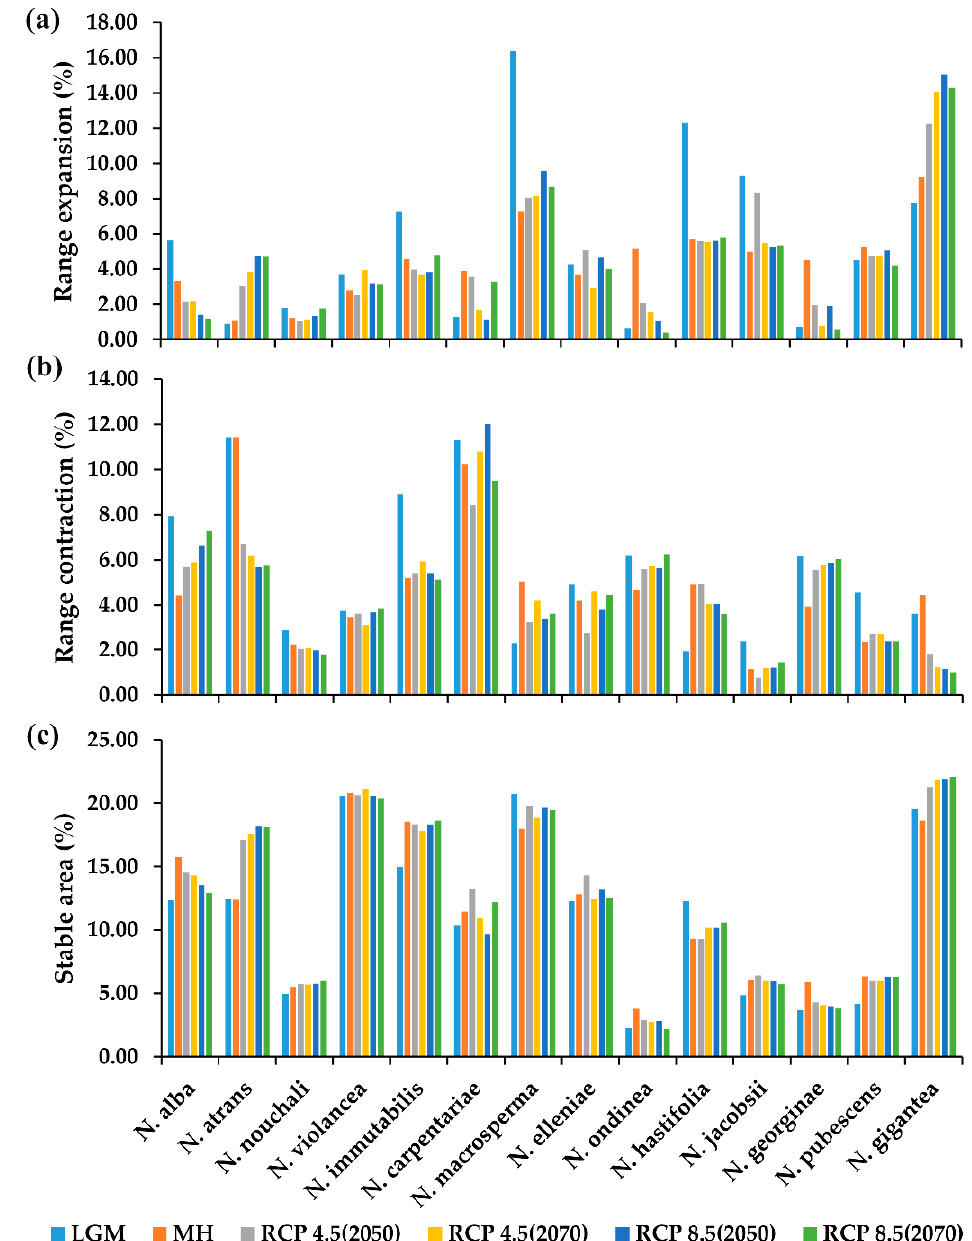
Figure 3. Change in habitat suitability for the past and future projections of water lilies in Australia: ( a ) range expansions, ( b ) range contractions, and ( c ) stable area. The expansion ranges for N. alba are projected to be greater in the LGM than the MH South of Australia and New South Wales. The island of Tasmania indicated stable